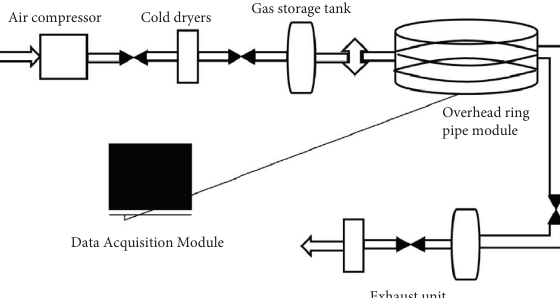
Figure 1: Diagram of the experimental system structure.